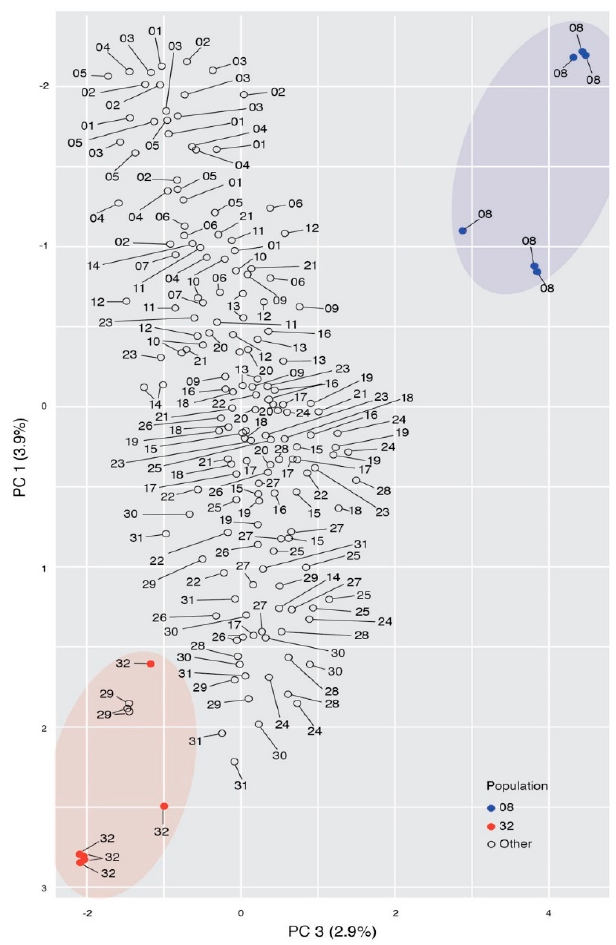
Figure 5. Principal component analysis (PCA) of genetic data for all 178 individuals in this study. Population 08-Mount Kaputar National Park (western extreme) is highlighted in blue and population 32-Brogo (southern extreme), in red.